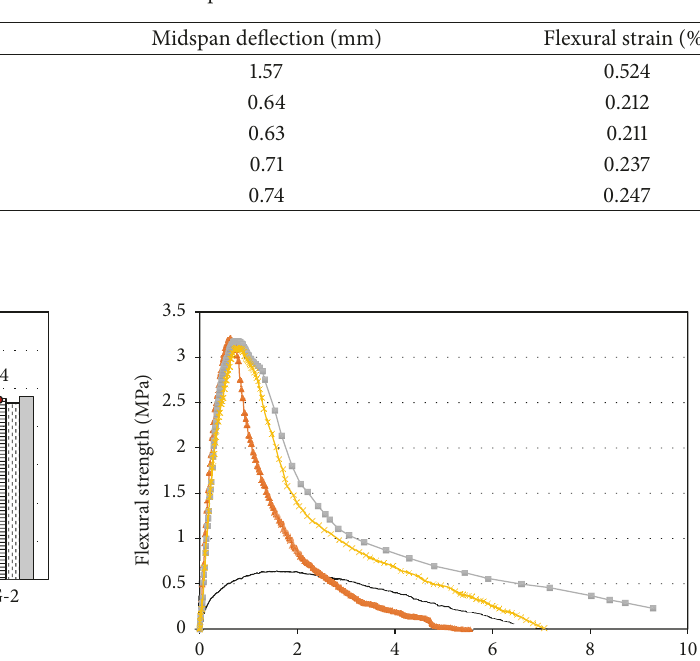
Table 4: Flexural test results of all specimens.